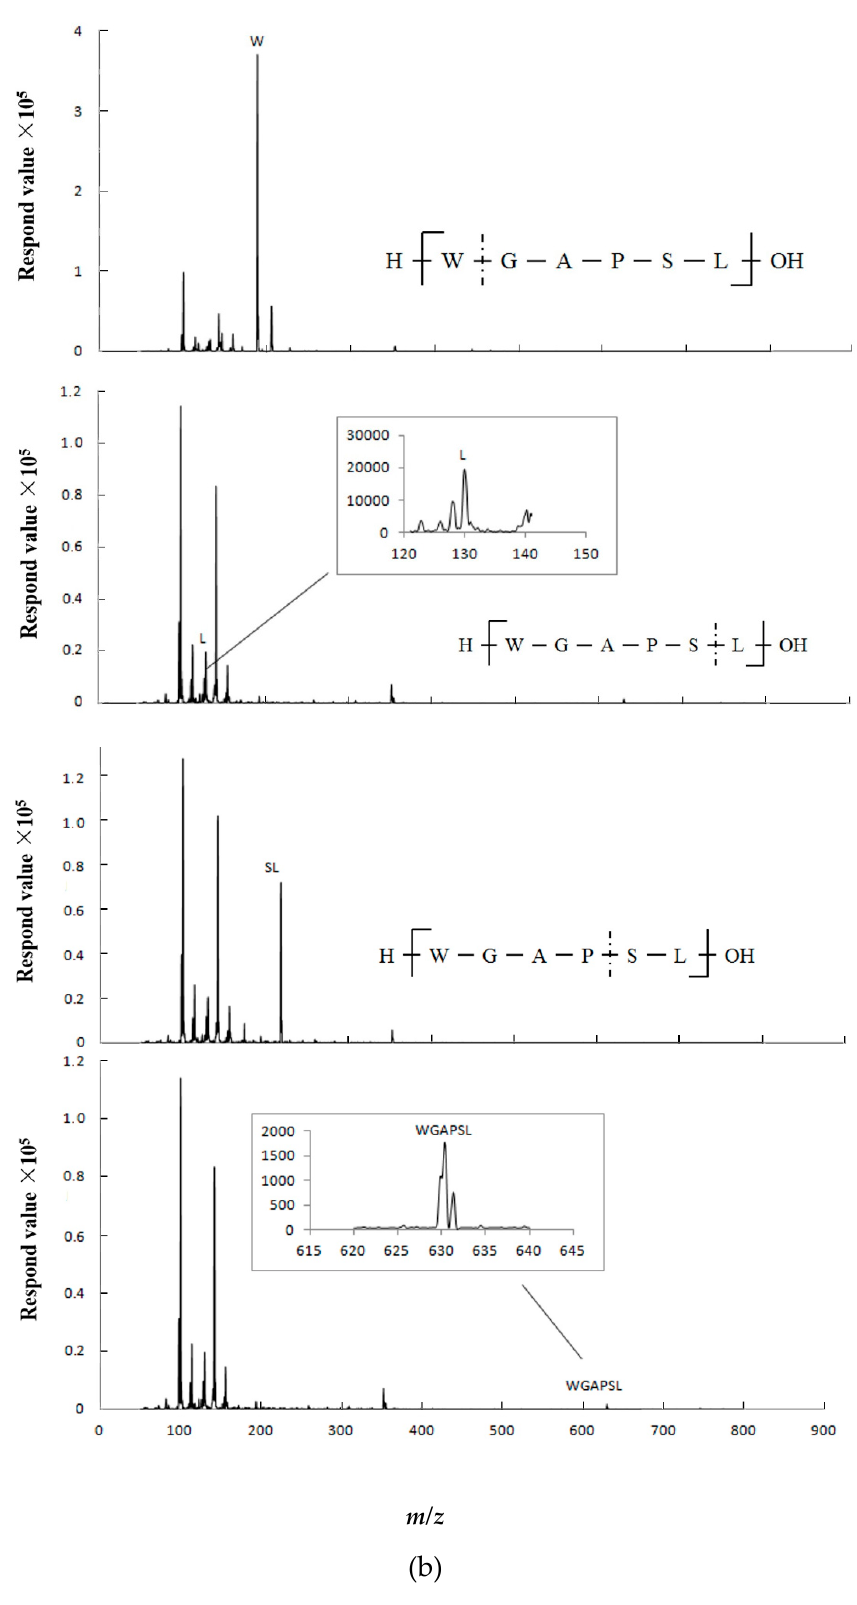
Figure 5. Fragments detected by LC-MS in apical (AP) ( a ) and basolateral (BL) ( b ) sides after the incubation of peptide WGAPSL in Caco-2 cell monolayers for 120 min. (Trp: W, Leu: L, and Ser-Leu: S-L).